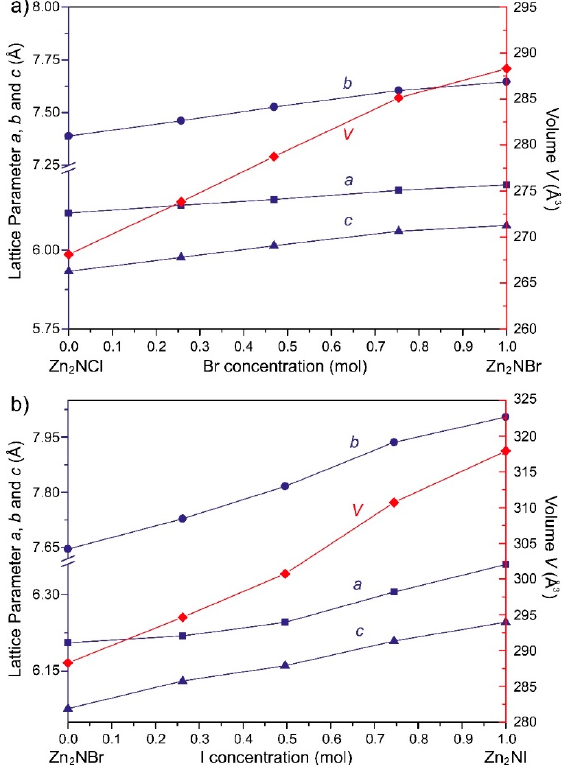
Figure 3. Course of the lattice parameters a , b, and c (left and blue) and volume V (right and red) based on XRPD data as a function of the bromide content for Zn 2 NCl 1 − y Br y ( a ) and the iodide content for Zn 2 NBr 1 − y I y ( b ).